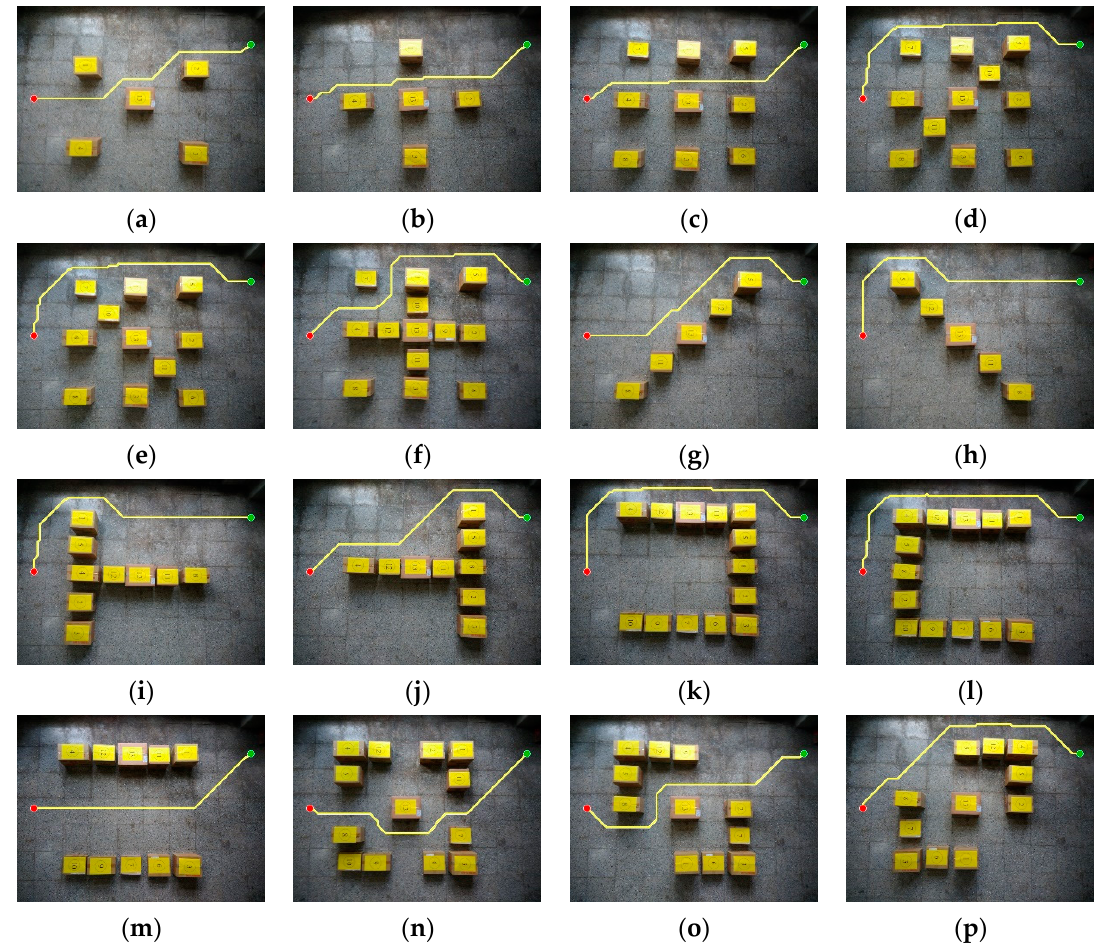
Figure 23. Planned paths shown in Experiment IV: ( a ) result #1; ( b ) result #2; ( c ) result #3; ( d ) result #4; ( e ) result #5; ( f ) result #6; ( g ) result #7; ( h ) result t #8; ( i ) result #9; ( j ) result #10; ( k ) result #11; ( l ) result #12; ( m ) result #13; ( n ) result #14; ( o ) result #15; ( p ) result #16.